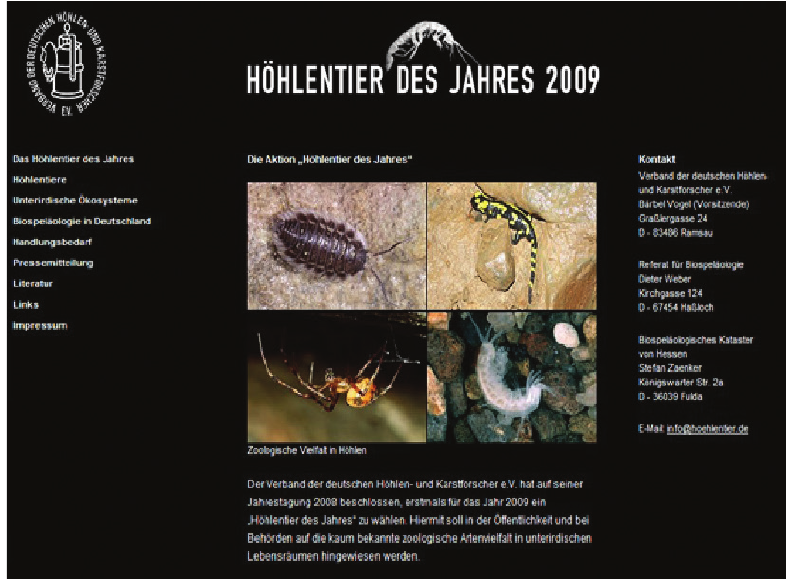
Figure 1. Homepage of the cave animal of the Table 1. Cave animals of the year from 2009 until 2017.